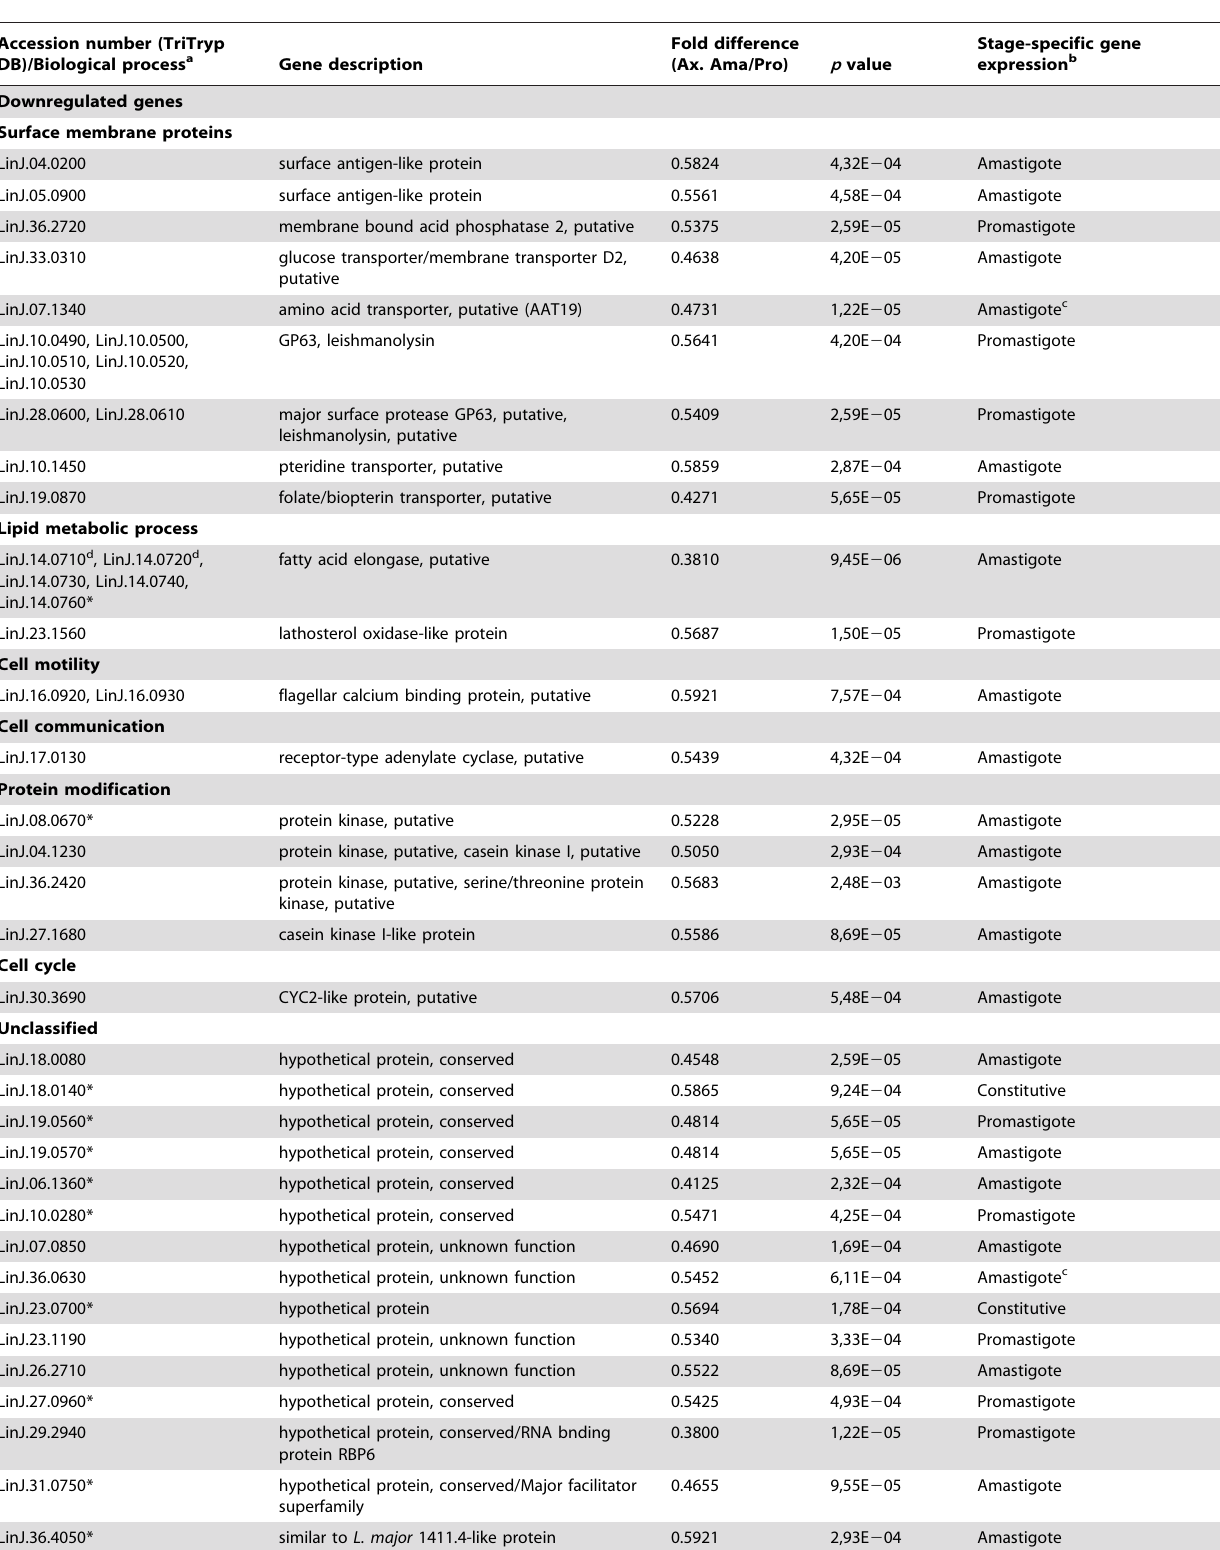
Table 1. Genes differentially expressed between Leishmania infantum wild type and Lin PIWI ( 2 / 2 ) axenic amastigotes as assessed by DNA microarray